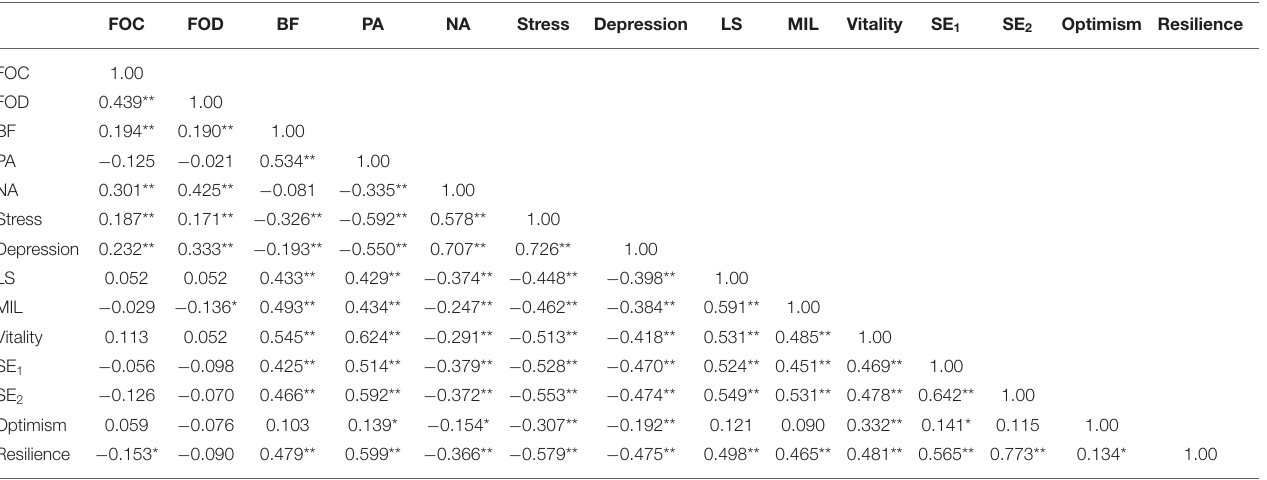
TABLE 2 | Preliminary analyses (i.e., correlations) between variables.